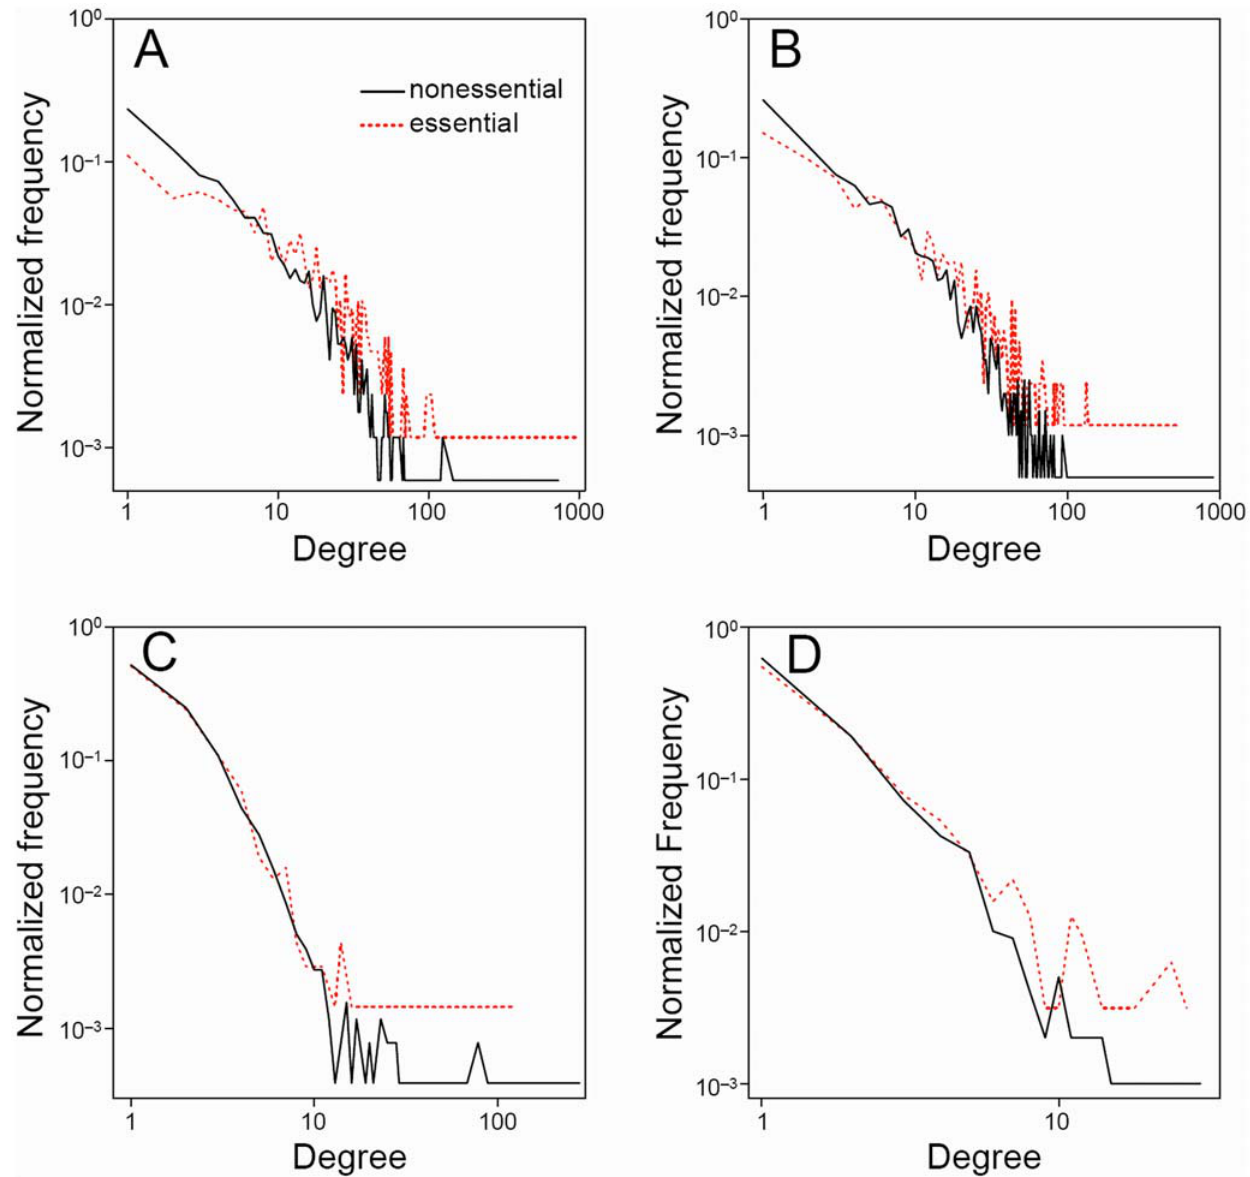
Figure 4. Degree distributions of essential (red dashed) and nonessential (black) proteins in raw yeast PPI networks. (A) Gavin (TAP) [5], (B) Krogan-TOF (TAP) [8], (C) Ito (Y2H) [7], (D) Uetz (Y2H)